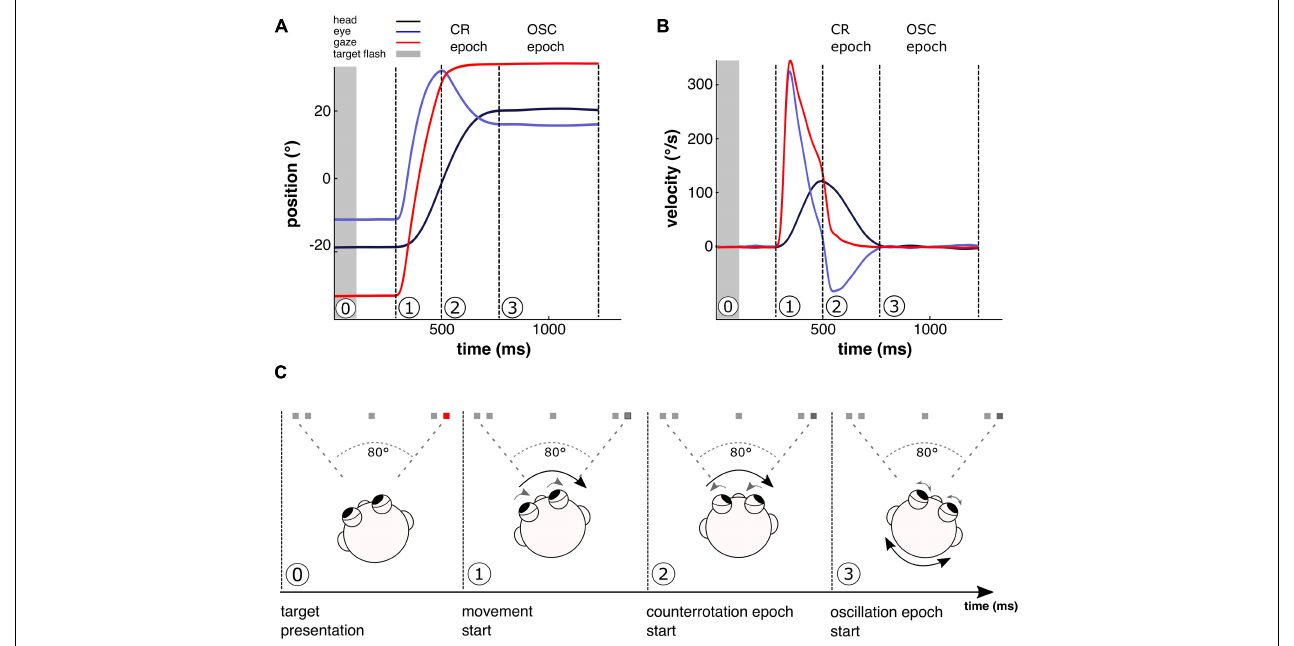
FIGURE 2 | Movement sequence over the course of a single 80 ◦ gaze shift. Shown are position (A) and velocity traces (B) of experimentally recorded eye and head movements during one exemplary 80 ◦ gaze shift as well as computed gaze movement. Gaze, i.e., the position of the eyes in space, is composed of eye position (recorded in relation to the head) and head position (recorded in relation to space). An 80 ◦ gaze shift requires combined eye–head movements and follows a typical sequence (C) , including two distinct gaze stabilization epochs. Beginning from the target position of the previous trial, quickly after the flashed target light ( 0 , gray bar in A , B , and red spot in C ) is extinguished, eyes and head begin to move jointly toward the remembered target position (dark spot in C ) in a coordinated and voluntarily planned way, representing the start of the gaze shift movement ( 1 ). Due to the active nature of head motion here, the vestibulo-ocular reflex (VOR) is suppressed (e.g., Angelaki and Cullen, 2008). When the gaze movement toward the target is finished, i.e., the eyes have reached maximum amplitude, but the head continues to move toward the target, the eyes counteract the continuing head movement by a counter-rotation (CR) in order to achieve stable gaze in this first stabilization epoch. Like the joint eye and head movement in epoch 1, the coordinated eye–head movements in this CR epoch are part of the active gaze shift, where movements are voluntarily planned, initiated, and executed to shift gaze toward the target position. Therefore, for gaze stabilization, motor planning is used to expect the sensory consequences of the head movement (e.g., Shanidze et al., 2010; King and Shanidze, 2011). The contribution of motor planning information on gaze stabilization in the CR epoch of this experimental paradigm has been demonstrated previously in bilateral vestibular loss patients (Saˇglam and Lehnen, 2014). Due to ongoing active head motion here, VOR is still suppressed in the CR epoch, although suppression is likely to be attenuated toward the end of the active movement (e.g., Lefèvre et al., 1992). When the head has finished its motion toward the target position, the active movement is completed ( 3 ). Now, the second stabilization epoch begins, where the eyes counteract small, unexpected passive head oscillations, further provoked by experimentally increased head inertia, which do not emerge as a consequence of motor planning of the active gaze shift. In this oscillation (OSC) epoch, in contrast to the CR epoch, no head movements are expected. Compensatory eye movements are driven by sensory feedback loops, mainly the VOR that is not suppressed